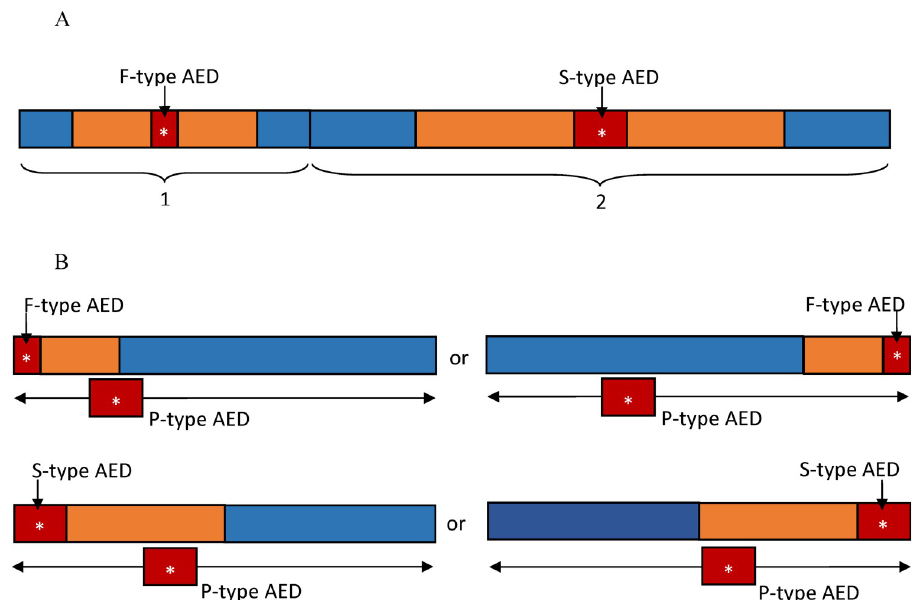
Fig 3. Illustration of the optimal deployment for two AEDs. (Fig 3A) One F-type and one S-type AED. In this case, one should divide the confined space into two parts with a 1-to-2 length ratio. The F-type AED is placed at the center of the shorter part, and the S- type AED is placed at the center of the longer part. (Fig 3B) One P-type AED and one F- type or S-type AED. In this case, the F-type or S-type AED is placed toward one of the end locations with its hot zone entirely contained in the confined space. The P- type AED patrols the entire space.